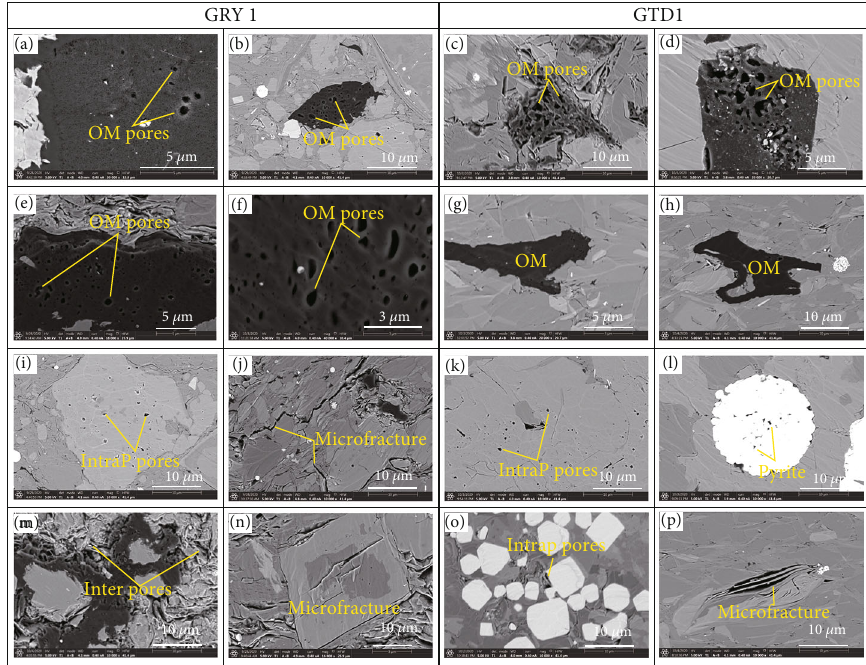
Figure 4: SEM photos of shale samples in well GRY1 and well GTD1: (a) round-oval organic pores, 1361.7m, well GRY1; (b) round-oval organic pores, 1367.4m, well GRY1; (c) collapse-closure organic pores, 1050.0m, well GTD1; (d) collapse-closure organic pores, 1050.0m, well GTD1; (e) round-oval organic pores, 1599.3m, well GRY1; (f) round-oval organic pores, 1534.8m, well GRY1; (g) irregular organic matter, 1178.4m, well GTD1; (h) irregular organic matter, 1235.9m, well GTD1; (i) intragranular pore, 1367.4m, well GRY1; (j) microfractures, 1628.3m, well GRY1; (k) intragranular pore, 1050.0 m, well GTD1; (l) pyrite framboids, 1050.0m, well GTD1; (m) intergranular pore, 1552.7m, well GRY1; (n) microfractures, 1599.3m, well GRY1; (o) intergranular pore, 1165.5m, well GTD1; (p) microfractures, 1235.9 m, well